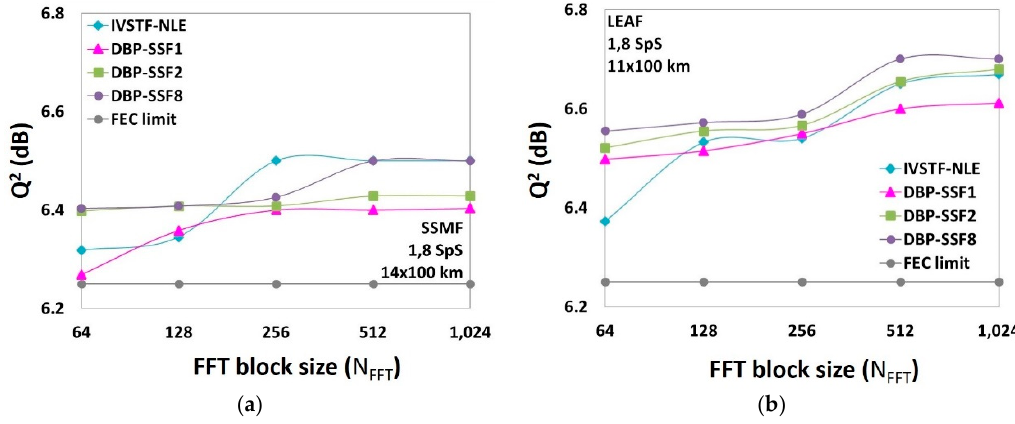
Figure 8. Q 2 -factor as a function of the N FFT , at the optimum input power per band, after ( a ) 14 × 100 km of SSMF and ( b ) 11 × 100 km of LEAF. Table 1. Maximum Q 2 -factor and the corresponding number of real multiplications per sample per polarization required at the optimum N FFT , after 14 × 100 km of SSMF at optimum input power equal to − 3 dBm.